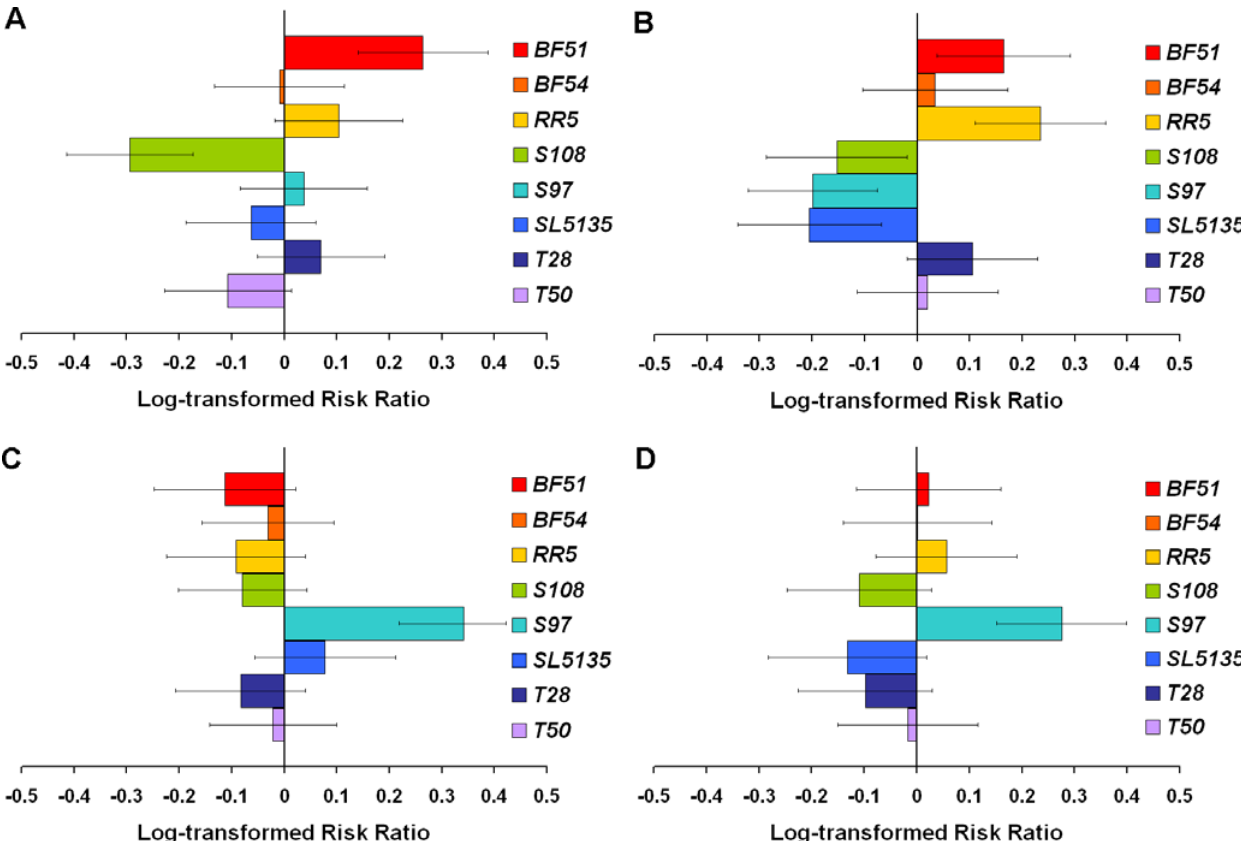
Figure 2. Risk ratios for each line over one of the mth mutants relative to that line over mth R3 . The comparisons using mth D 6 are on the left ( A and C ); the comparisons using mth 1 are on the right ( B and D ). Females are above ( A and B ), males below ( C and D ). Positive ratios indicate greater risk of death, so the positive ratios for BF51 females ( A and B ) mean that this line showed lower expected lifespan over the mth mutants than over the mth wild-type allele. The heterogeneity in the magnitude and direction of relative risk represents the functional diversity in lifespan among the wild mth lines. Error bars show 95% confidence. Error bars which do not cross the y-axis signify a failure to complement in that line.